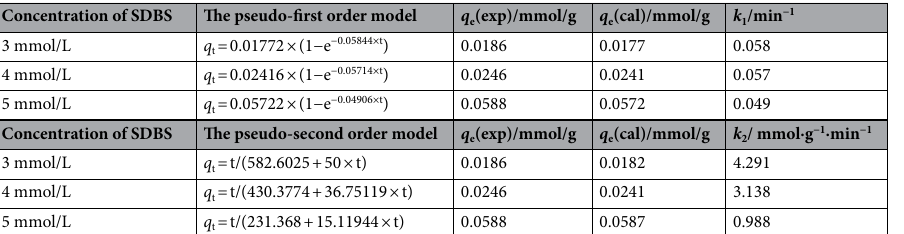
Concentration of SDBS The pseudo-first order